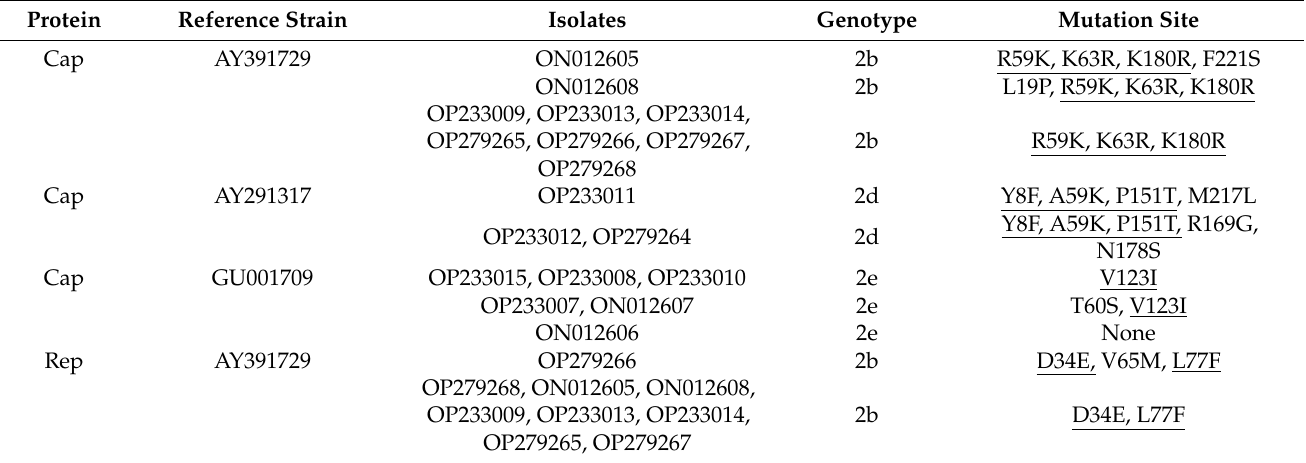
Table 2. Mutations in the Cap and Rep proteins of PCV2 isolates compared with that of the AY391729 (PCV2b), AY291317 (PCV2d), and GU001709